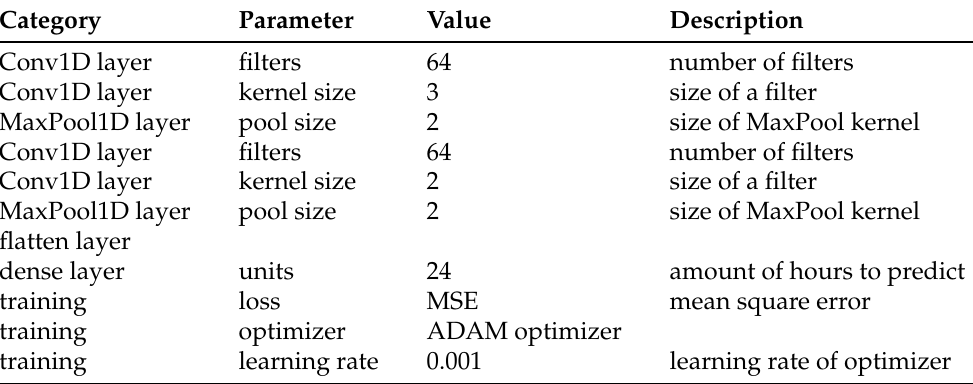
Table A3. Architecture of the convolutional network.